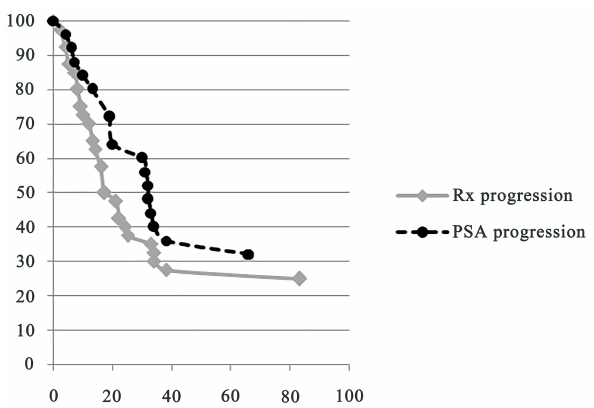
Fig. 3. Overall survival (in months) of patients whose second line antihormonal treatment was stopped at radiological (Rx) vs. biological (PSA)